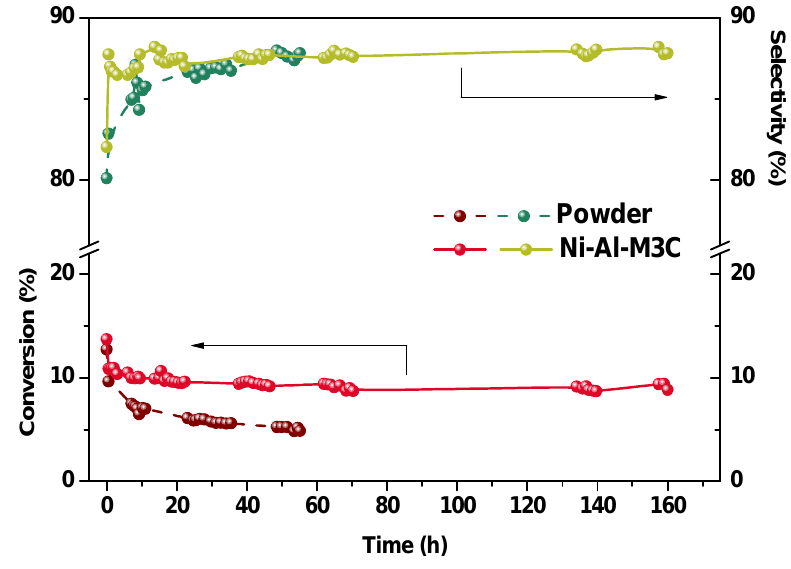
Figure 10. Structured and powder catalysts stability in reaction, T = 450 °C and W/F = 0.48 g ∙ s/cm 3 .